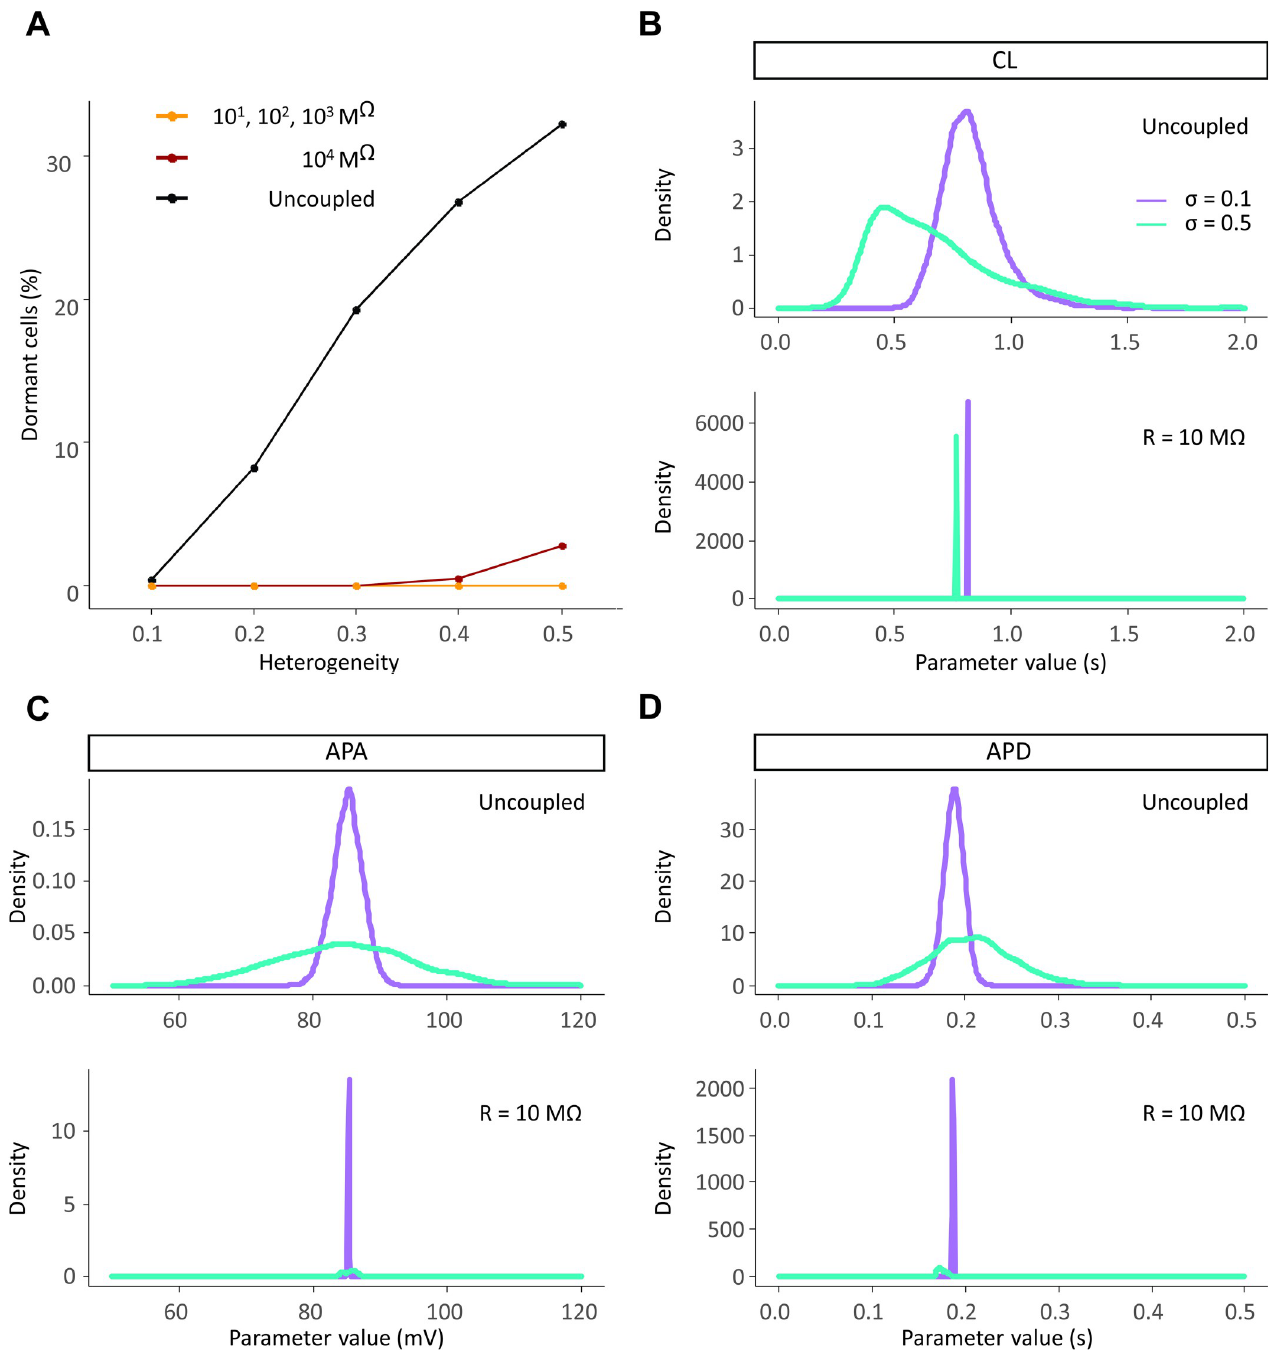
Fig 5. SAN cells synchronize their electrical properties when coupled in a tissue. (A) When coupled together heterogeneous SAN cells give rise to a spontaneously beating tissue. The only exception occurs at very high values of heterogeneity ( σ equal to 0.4 and 0.5, with 0.5% and 2.8% of dormant cells respectively) and very high levels of intercellular resistance (R = 10,000 M O ). (B-D) The population of cells synchronizes its AP metrics: cycle length (CL), action potential amplitude (APA) and action potential duration (APD) when well-connected in tissue.